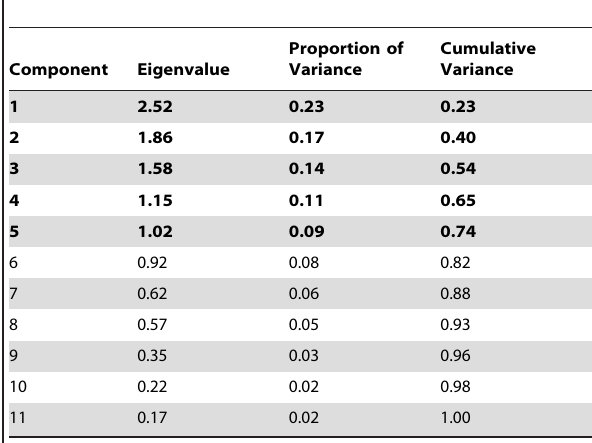
Table 6. Eigenvalues and their proportion of explained variance from Principal component